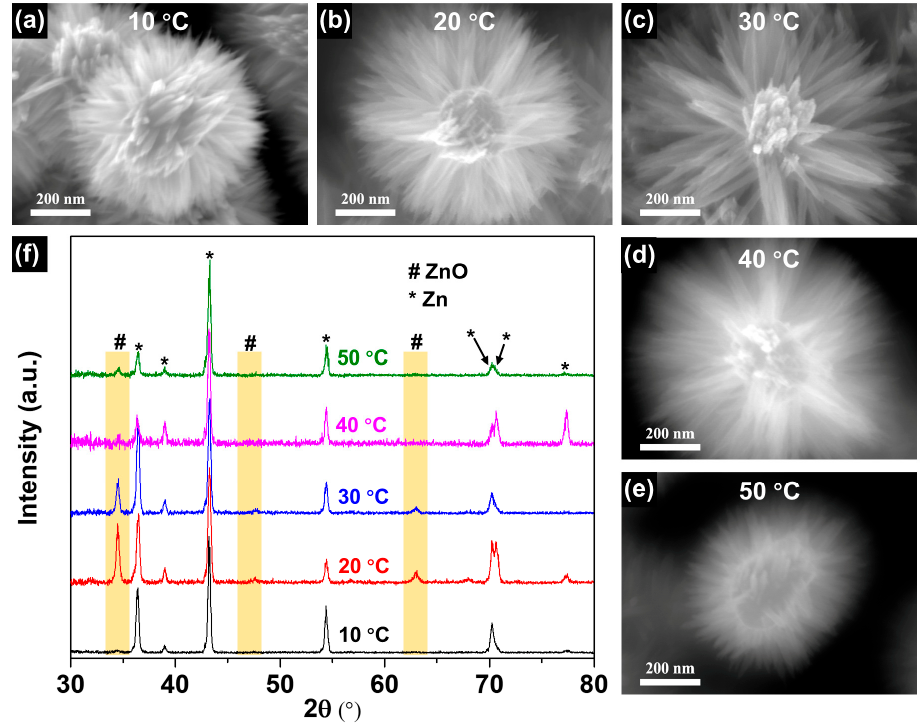
Figure 3. SEM images of B-ZnO NWA prepared at ( a ) 10 °C, ( b ) 20 °C, ( c ) 30 °C, ( d ) 40 °C, and ( e ) 50 °C. ( f ) XRD patterns of B-ZnO NWA prepared at different temperatures.